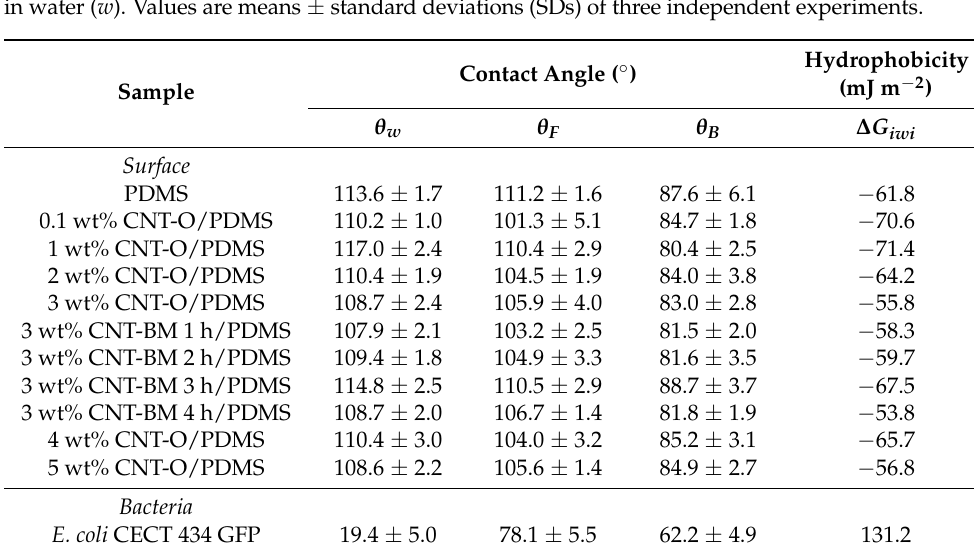
Figure 2. Pore size distributions obtained by Non-Linear Density Function Theory. Table 2. Contact angles with water ( θ w ), formamide ( θ F ) and α -bromonaphthalene ( θ B ), and free energy of interaction ( ∆ G iwi ) between two entities of a given material ( i ) (surface or bacteria) when immersed in water ( w ). Values are means ± standard deviations (SDs) of three independent